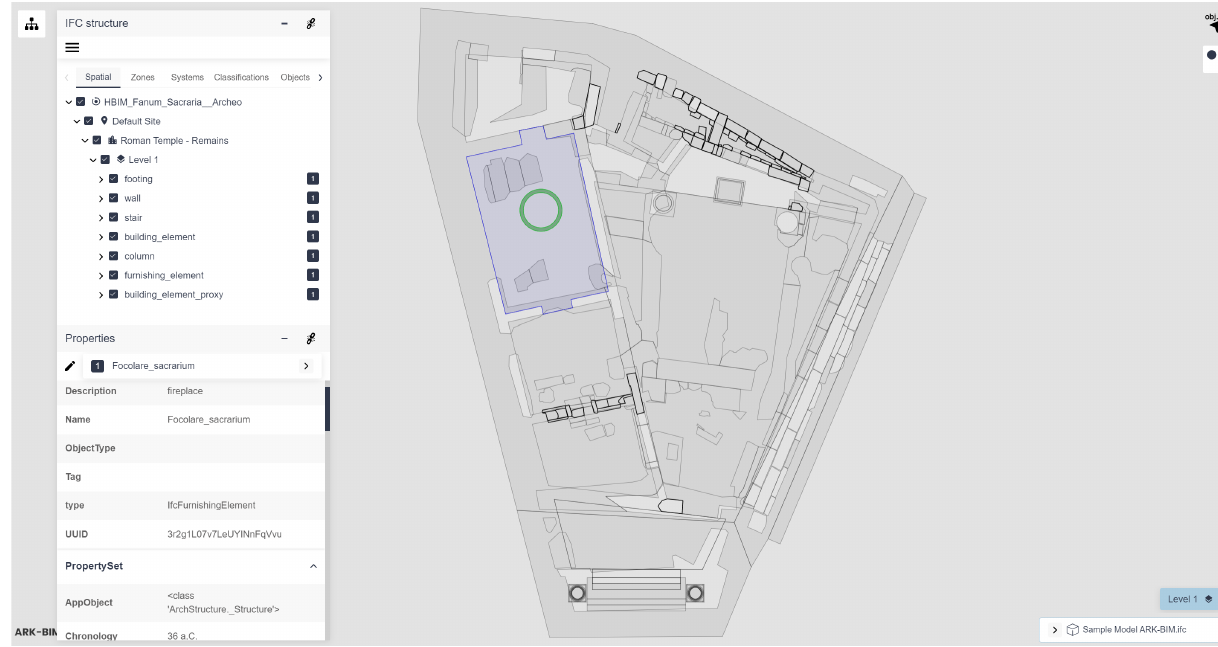
Figure 9. ARK-BIM (version 1.5.1): unlocked 2D-3D switch plugin for visualizing ground plans of IFC models and related elements.